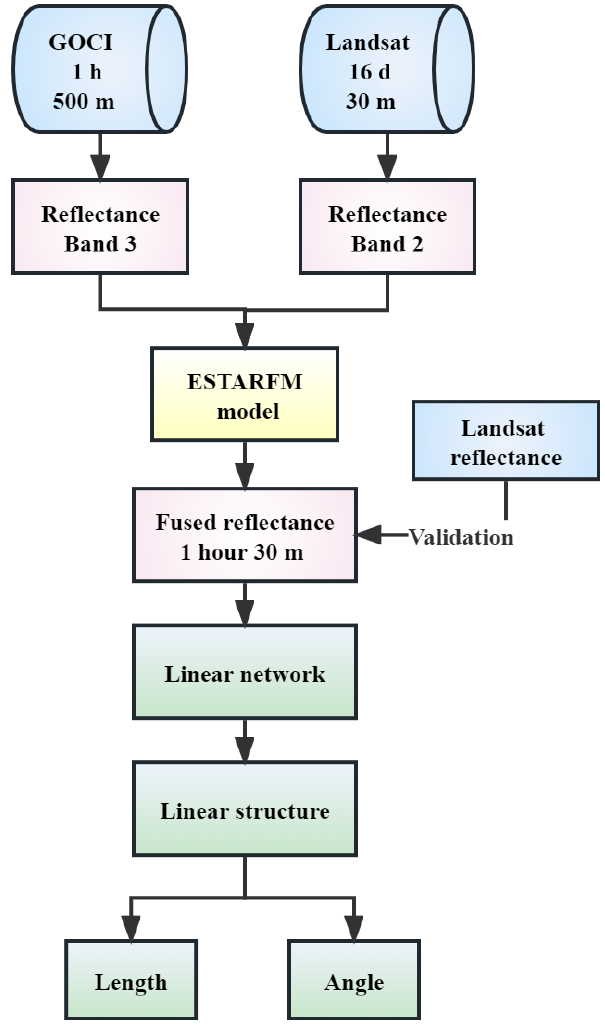
Figure 2. The workflow of this